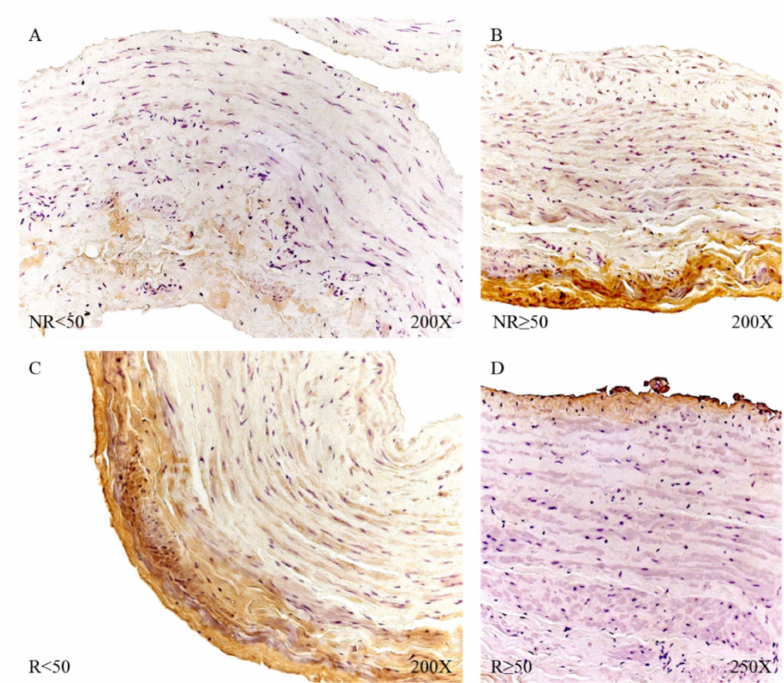
Figure 15. Fibrillin 1 protein expression images in patients NR < 50 ( A ), NR > 50 ( B ), R < 50 ( C ) and R > 50 ( D ).